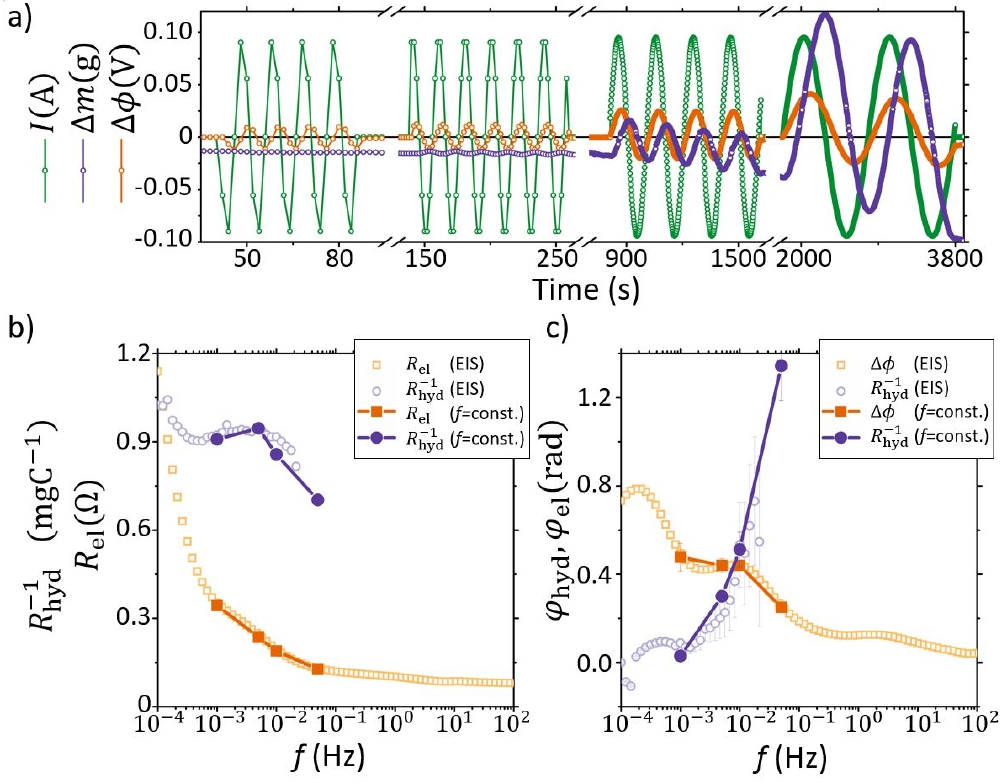
Figure 4. ( a ) Raw data for the dynamic response with Nafion 212. An alternating current ( I , green) is applied with constant frequency and amplitude. The phase shift between the potential difference ( ∆ φ , orange) and the mass transport through the membrane ( ∆ m , purple) is in particular seen at low frequencies. ( b , c ) Bode plot of the data in panel a along with results from Electrochemical Impedance Spectroscopy (EIS) ( b ) amplitude of the sinewave for the electro-osmotic coupling factor ( R − 1 purple) and magnitude of electrical impedance ( R el = ∆ φ / I , orange) versus frequency ( f ). ( c ) Phase shift ( ϕ ) for ∆ φ and ∆ m / ∆ t with respect to I . In the Bode plot two independent measurements are shown, one is obtained with an EIS station (hollow symbols), while the other is obtained with a programmable electrical source/load (filled